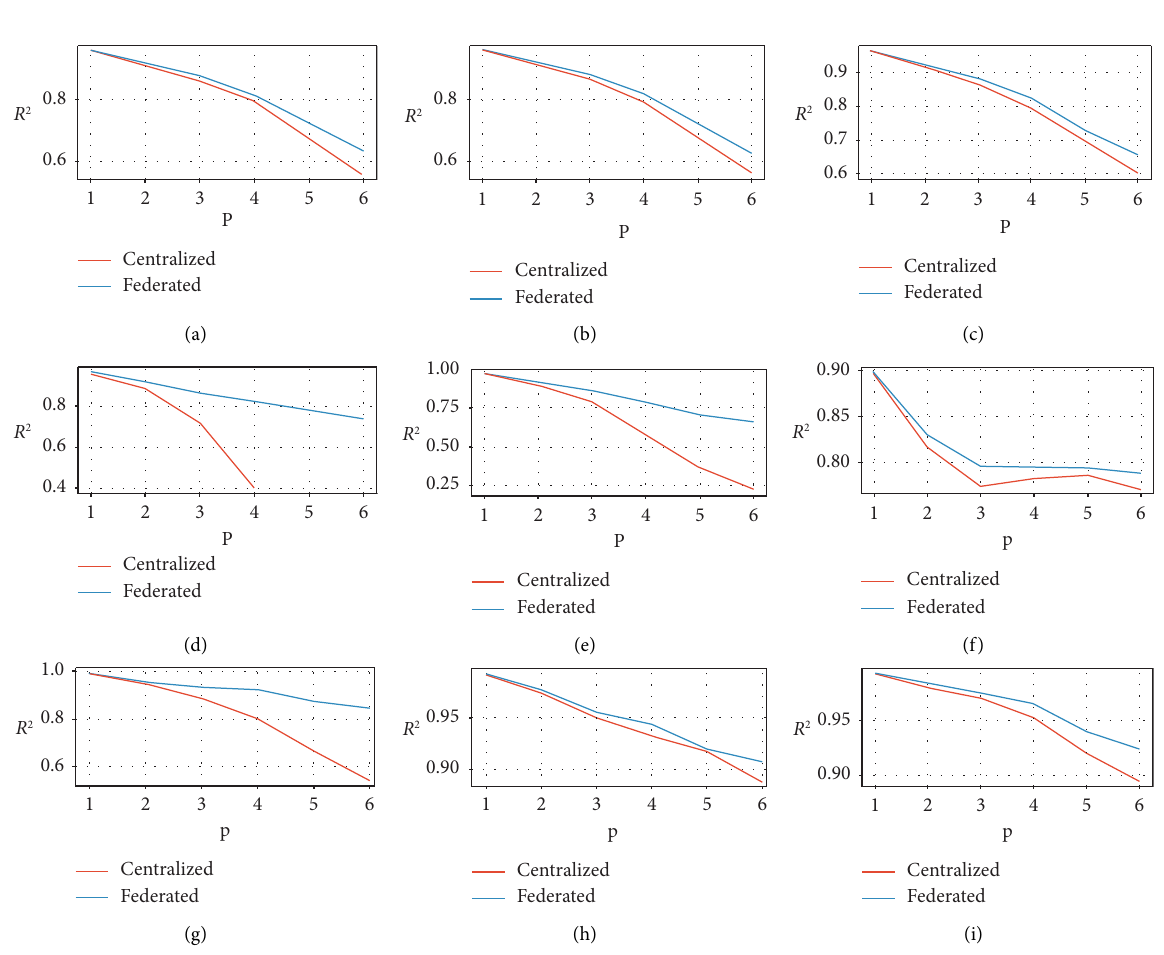
Figure 5: Comparison of centralized learning and two-part federated learning when t � 6 , 12 , 24. (a) Dataset-1, t � 6. (b) Dataset-1, t � 12. (c) Dataset-1, t � 24. (d) Dataset-2, t � 6. (e) Dataset-2, t � 12. (f) Dataset-2, t � 24. (g) Dataset-3, t � 6. (h) Dataset-3, t � 12. (i) Dataset-3, t � 24. Table 2: Comparison of R 2 and runtime between centralized learning and three-party FL on